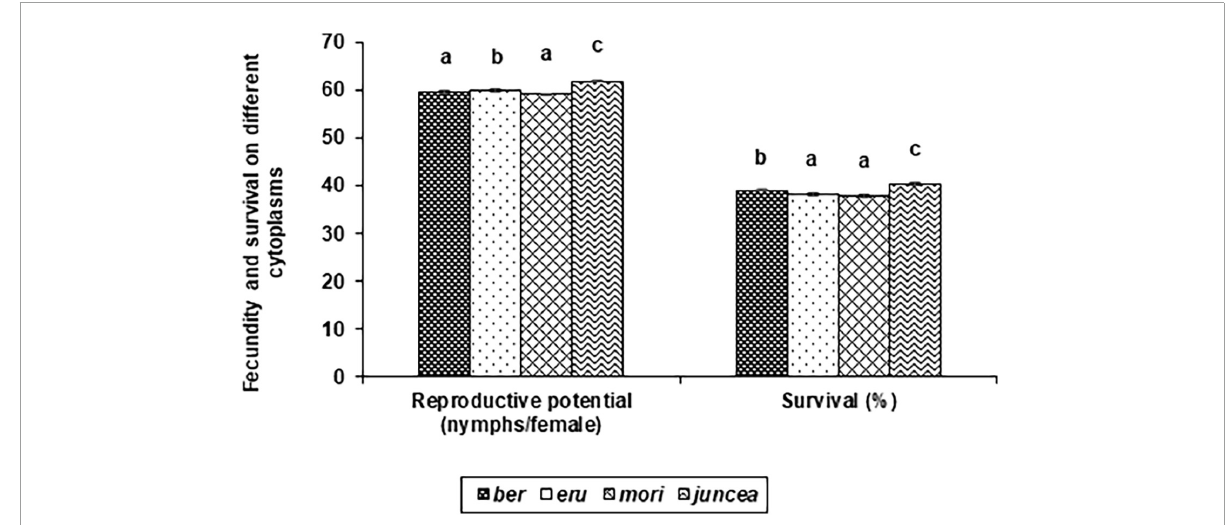
FIGURE3 Effects of cytoplasms on reproductive potential and survival Lipaphis erysimi in Brassica